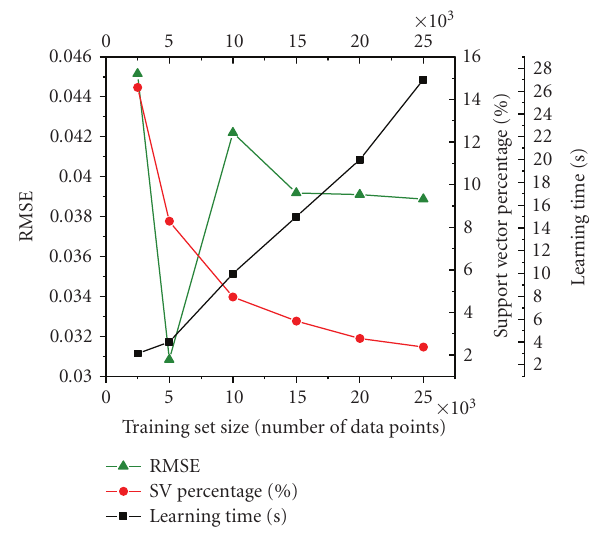
Figure 2: Training set size influence on model quality for k e ff BOC - preliminary